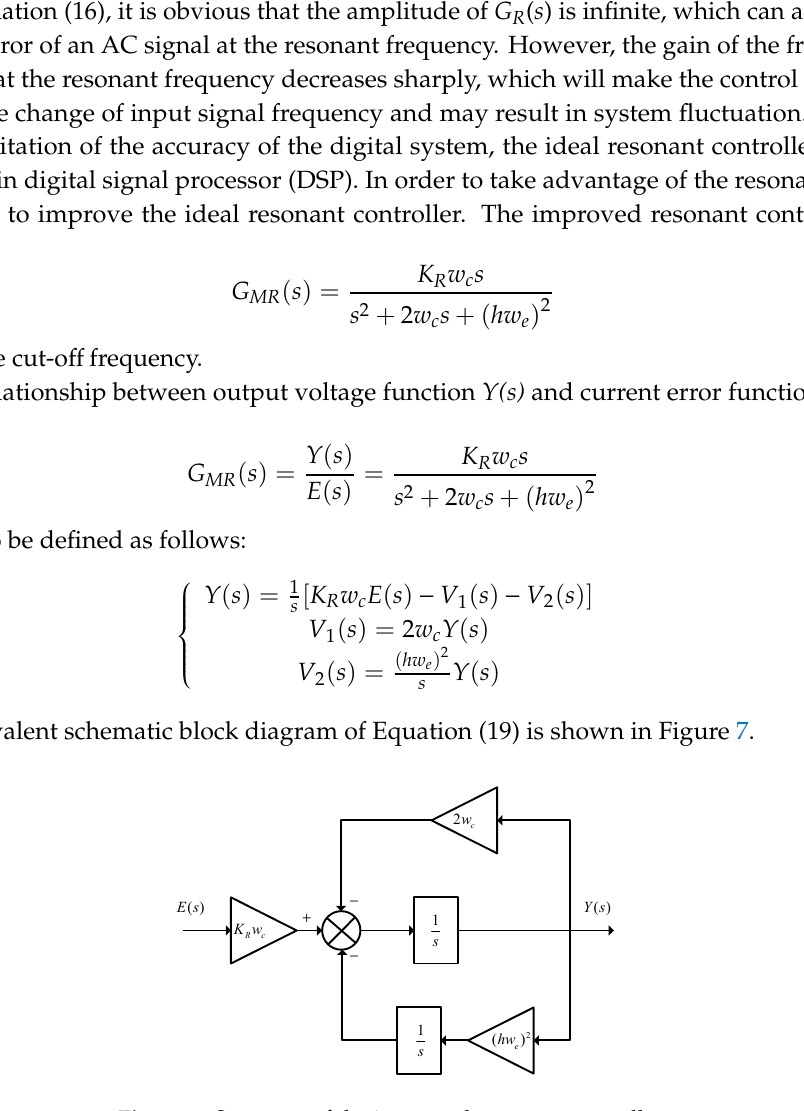
Bode Diagram Frequency (rad/s)